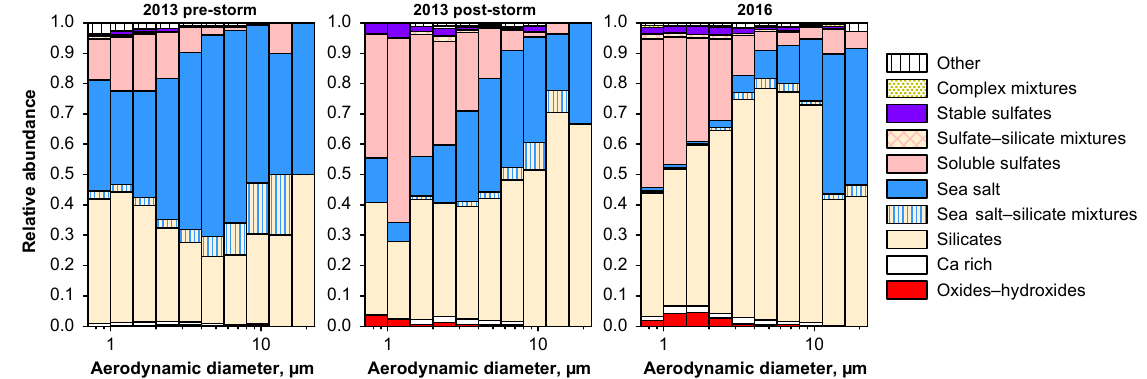
Figure 11. Size dependence of the relative number abundance of major particle types, as derived from single particle analysis of deposited